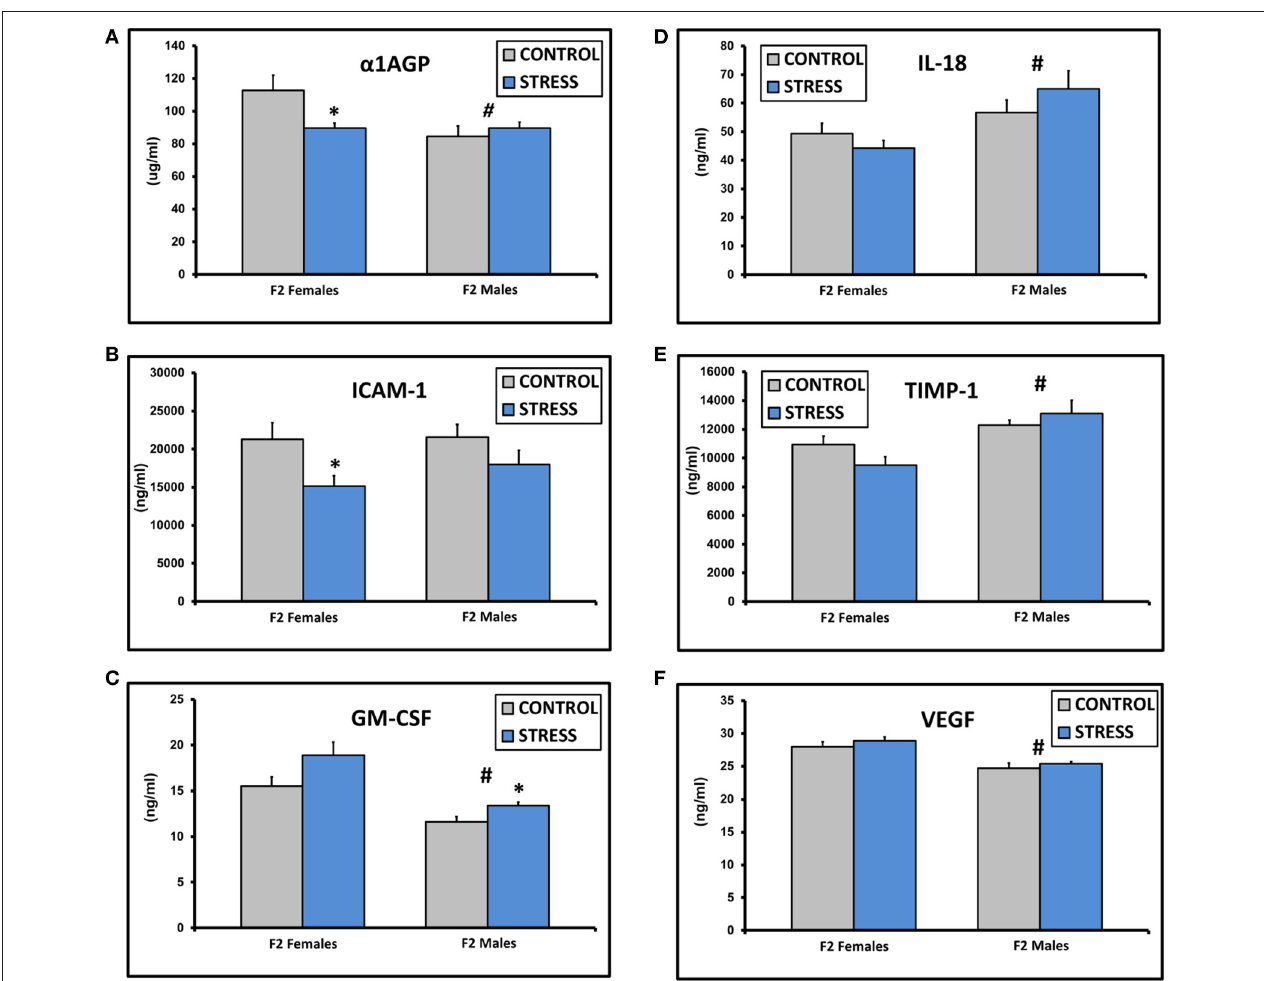
FIGURE 2 | Mean ± SEM basal plasma levels of α -1AGP (A), ICAM-1 (B), GM-CSF (C), IL-18 (D), TIMP-1 (E), and VEGF (F) in the adult F2 male and female offspring of control dams and dams exposed to chronic social stress during lactation. * Denotes significant effect of CSS treatment, # denotes significant effect of sex ( p < 0.05